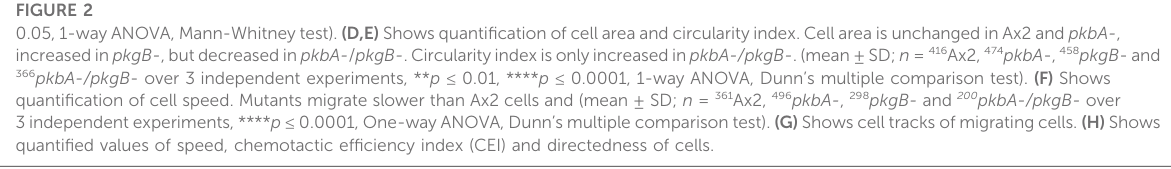
FIGURE 2 0.05, 1-way ANOVA, Mann-Whitney test). (D,E) Shows quanti fi cation of cell area and circularity index. Cell area is unchanged in Ax2 and pkbA- , increasedin pkgB- ,butdecreasedin pkbA- / pkgB- .Circularityindexisonlyincreasedin pkbA-/pkgB- .(mean±SD; n = 416 Ax2, 474 pkbA -, 458 pkgB